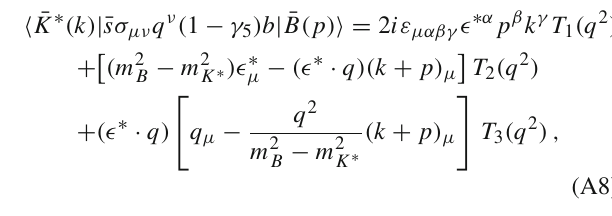
coefficient by imposing the relation f + ( 0 ) = f 0 ( 0 ) . we remove the a 0 2 The covariance matrix is provided with more digits in an ancillary file. / d.o.f (cid:15) 9 . 2 / 10). We See text for more min